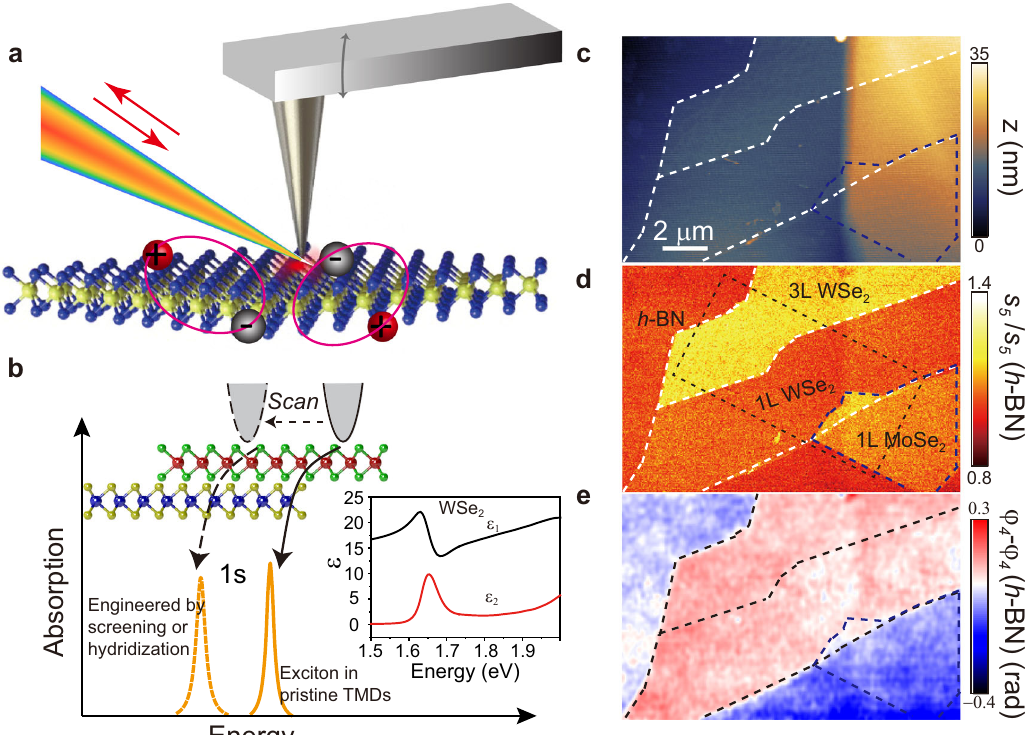
Fig. 1 Near- fi eld nano-probing of excitons in atomically thin transition metal dichalcogendies (TMDs). a Schematic illustration of near- fi eld measurement of excitons. The metallized AFM tip is illuminated by focused incident light and the tip-scattered light is collected. Pairs of electrons and holes with strong Coulomb interactions in atomically thin TMDs form excitons with large binding energies. The nanoscale response of excitons is extracted from the back-scattered light. b Scanning the tip across the TMD sample allows one to investigate the excitonic response below the diffraction limit and extract the dielectric function at the nanometer scale. The inset shows the dielectric function of monolayer WSe 2 from ref. 61 c An AFM topographic image of the TMDs in this study. The height difference between the left and right regions is due to the h-BN terrace. d , e Near- fi eld images of normalized scattering amplitude s 5 and phase φ on the same region of ( c ). The excitation energy is 1.68 eV. The dashed bright and blue lines trace the edges of the 4 different sample regions. The dashed rectangle marks the position of Fig. varying the photon energy with a step size of ~10 meV. We have simultaneously collected topographic and near- fi eld maps at each energy over the same FOV marked by the dashed rectangle in Fig. 1d. The topography image and height pro fi le are shown in Supplementary Fig. 3. The unobscured h-BN in the upper left corner of Fig. 2 is used as a reference for normalization purposes.